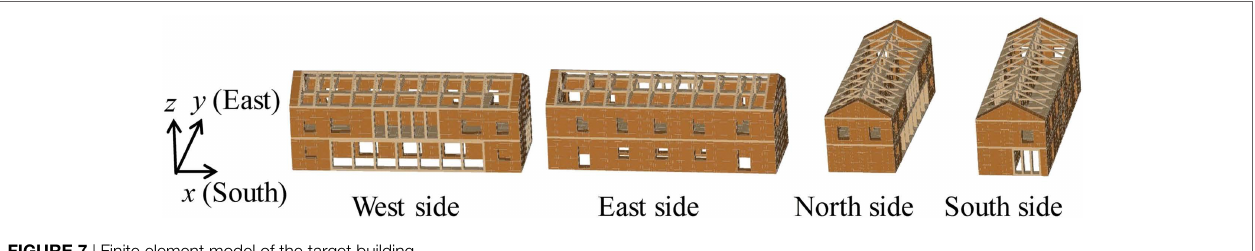
FIGURE 7 | Finite element model of the target building.